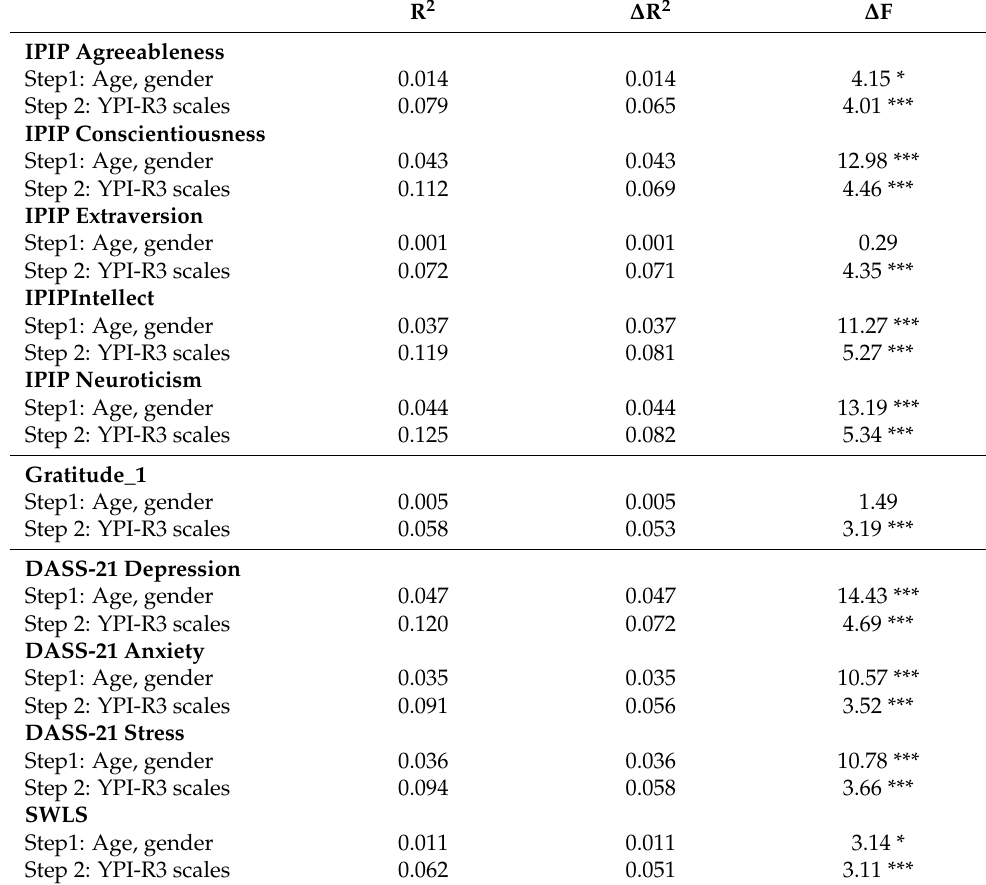
Table 8. Hierarchical regression analysis of the YPI-R3 predicting the IPIP, Gratitude, DASS-21, SWLS and Humor scales using the Singapore fathers’ sample ( n = 592). R 2 ∆ R 2 ∆